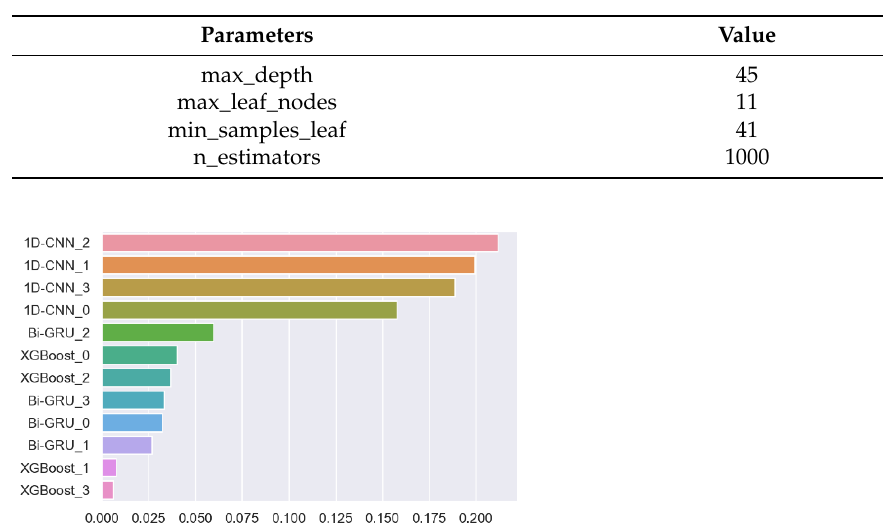
Figure 32. MFELCM1 feature importance .